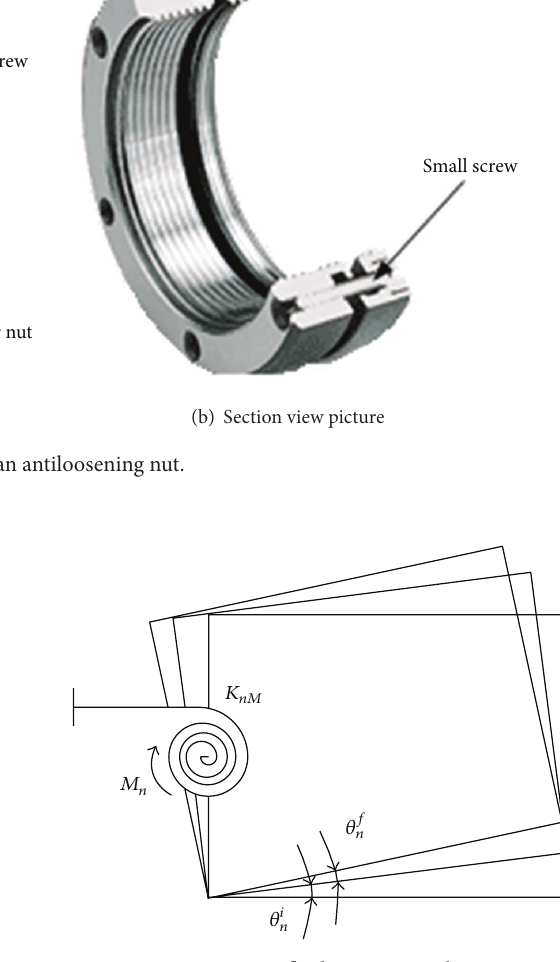
Figure 3: Nut flank rotation